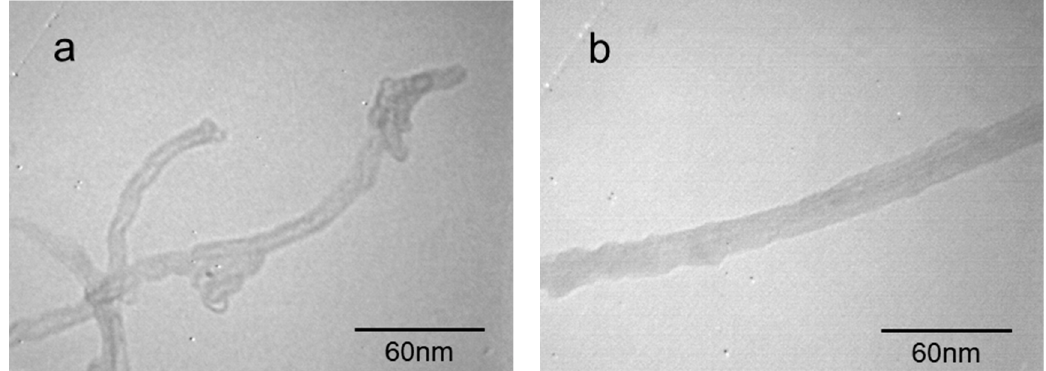
Figure 5. TEM images of ( a ) amino ‐ MWCNTs and ( b ) PAN grafted amino ‐ MWCNTs nanocomposites.